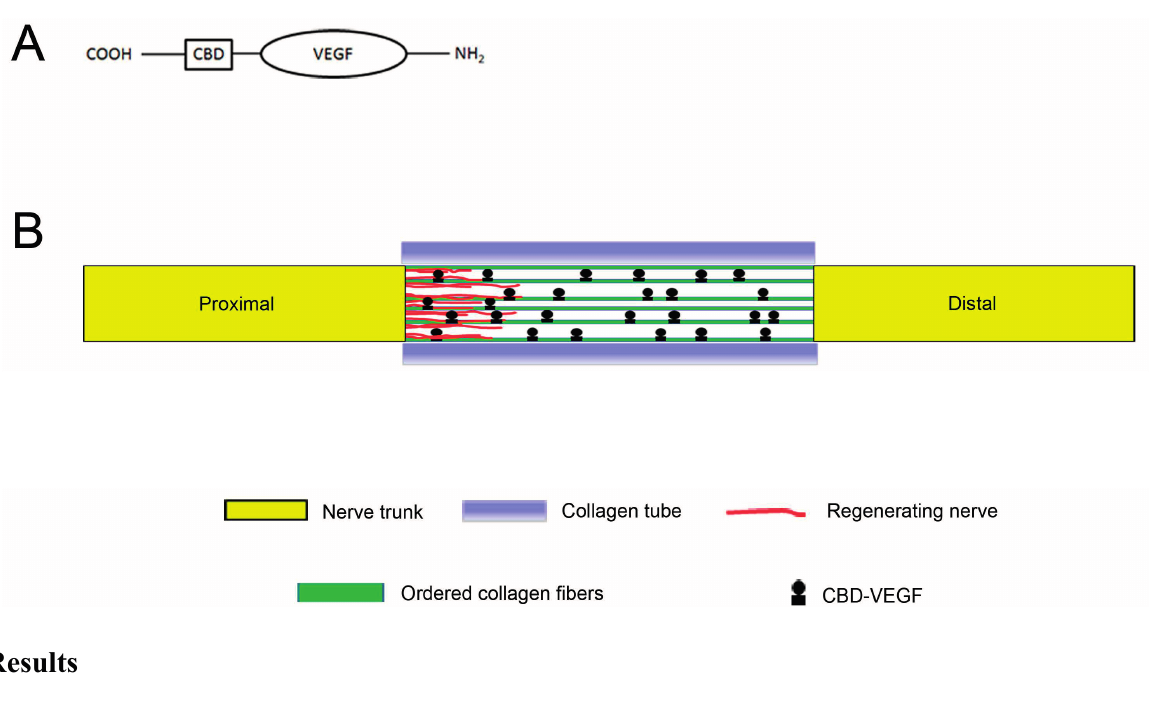
Figure 1. Natural neural scaffold design. ( A ) Diagram of the engineered vascular endothelial growth factor; and ( B ) Schematic diagram showing the natural neural scaffolds for nerve